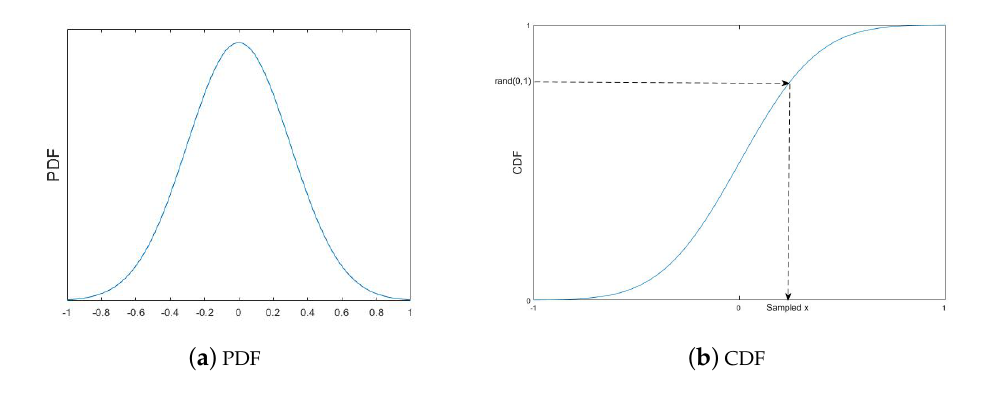
Figure 1. Sampling mechanism.